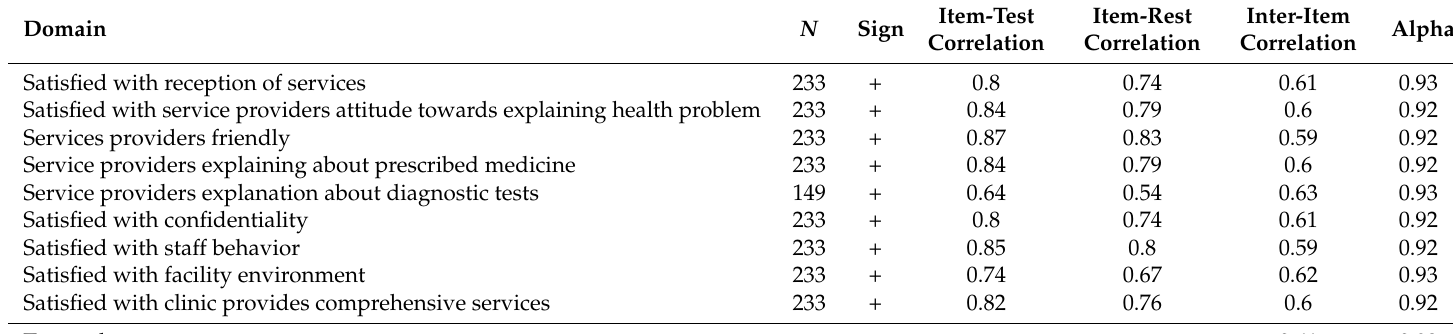
Table 5. Standardized satisfaction items test scale on self-financed health